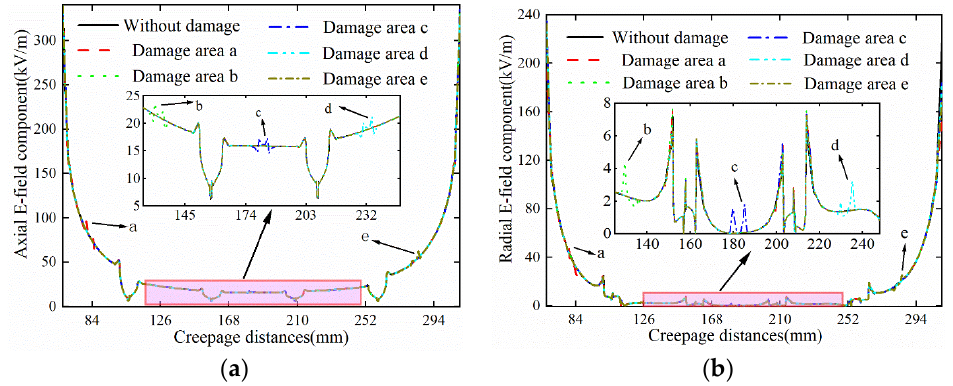
Figure 4. Distribution curves of the surface of the damaged composite insulator: ( a ) axial electric field; ( b ) radial electric field.